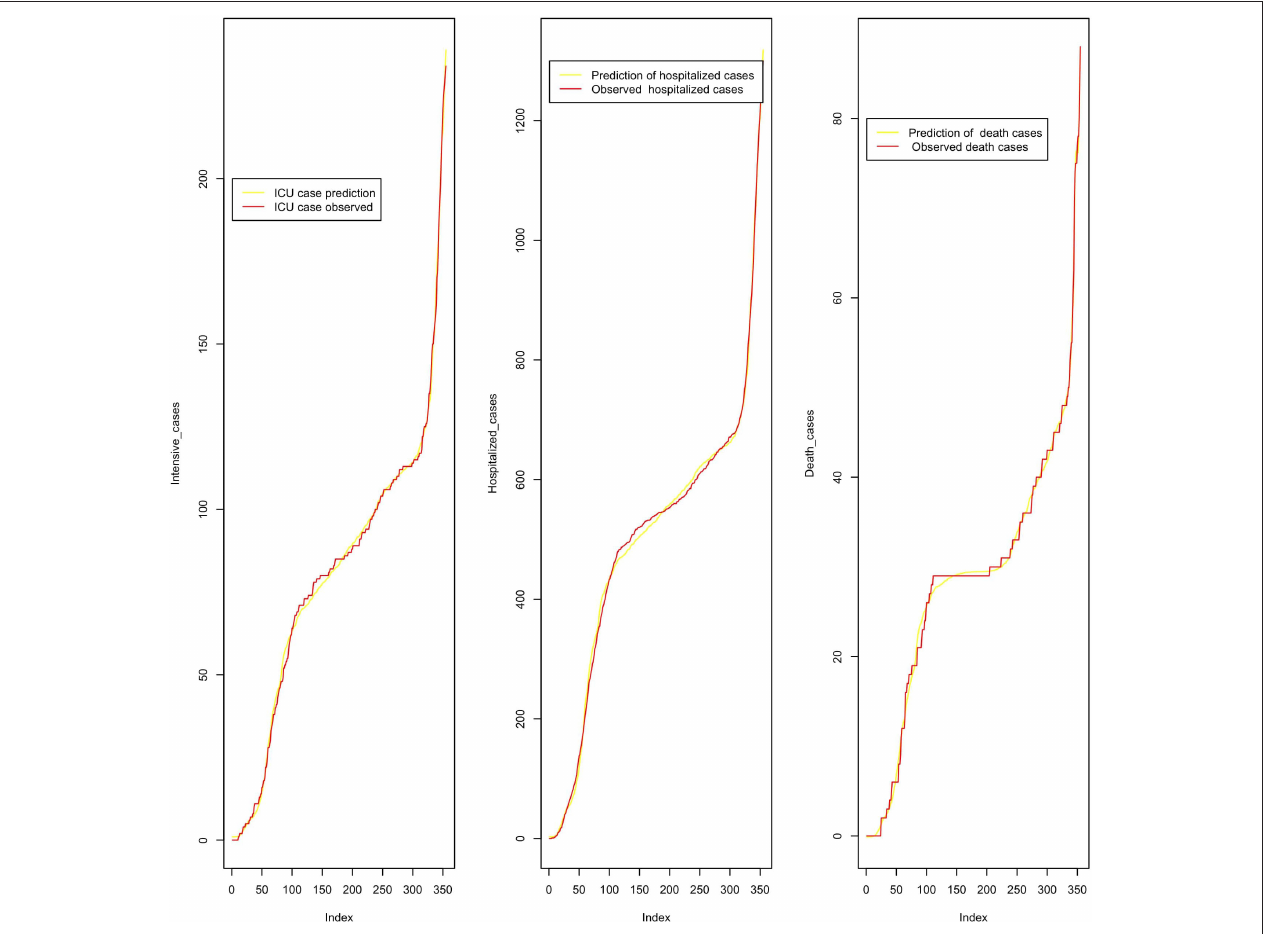
FIGURE 10 | Predicted cumulative intensive care, hospitalized, and death cases from March 2020 to February